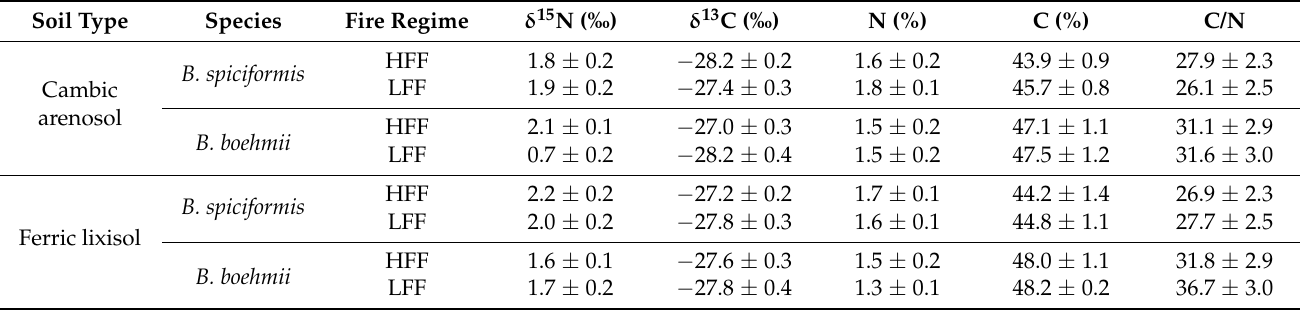
Table 3. Values for δ 15 N (‰), δ 13 C (‰), N (%), C (%), and C/N ratio in Brachystegia spiciformis and Brachystegoa boehmii leaves collected from plants grown in cambic arenosol and ferric lixisol soils, submitted to low (HFF) and high (HFF) fire